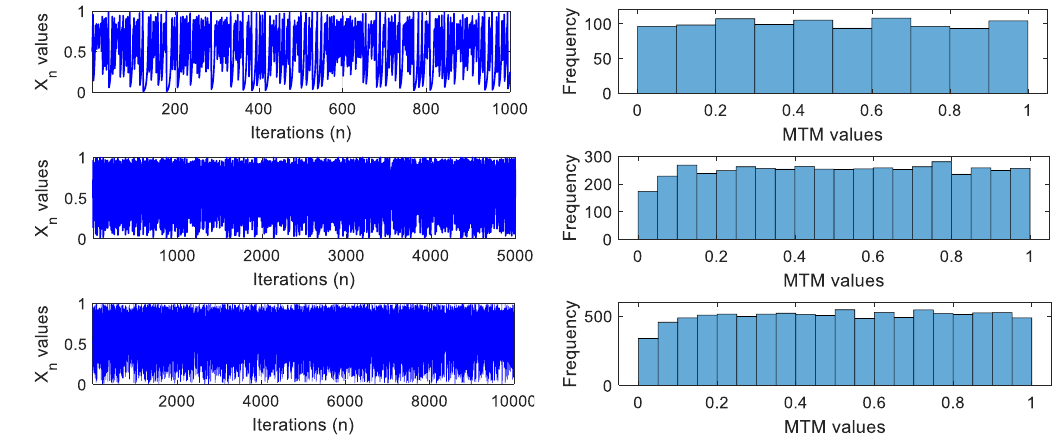
Figure 6. ( a ) Chaotic sequence with different sizes generated by MTM with their histograms with ( λ 1 , λ 2 , λ 3 , λ 4 , λ 5 , λ 6 ) are randomly set to ( a ) ( 6,2,1,7,5,3 ) , ( b ) ( 0.5,2,8.9,3.6,10,0.1 ) , and ( c ) ( 1,0.5,1,0,1000,0.0002 ) , respectively, with ( α , X 0 ) =